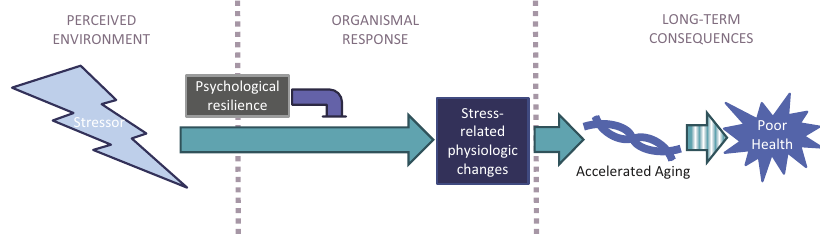
Fig. 1 Model of relationships between cumulative stress, resilience, physiology, and aging. We hypothesize that stress is positively associated with accelerated biological aging, which we measure via GrimAge Acceleration (GAA), and that this relationship will be mediated by stress-related physiologic changes such as insulin and HPA signaling. We also hypothesize that strong psychological resilience factors will be protective against the negative consequences of stress on aging. Note that these relationships are predictive, not causative, as this study is cross-sectional and thus directionality of relationships cannot be conclusively